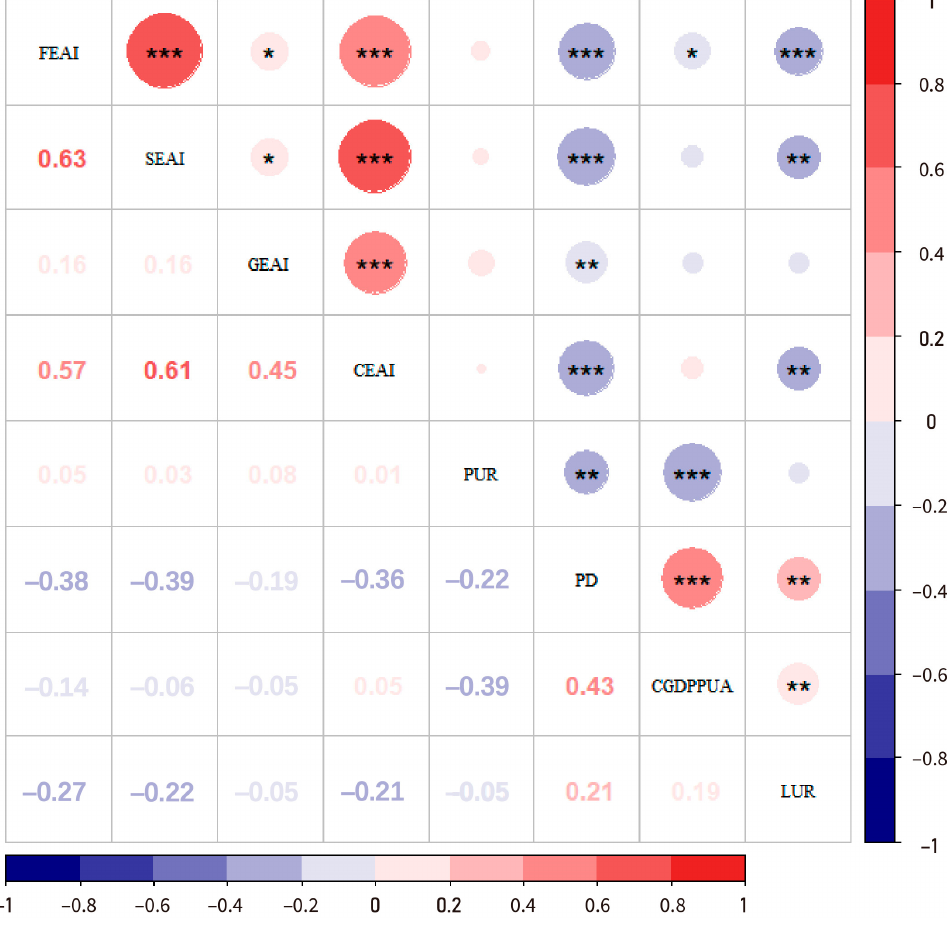
Figure 13. Correlation between county-level urbanization development and ecosystem asset index changes in the Beijing–Tianjin–Hebei urban agglomeration from 2000 to 2015. Note: *** represents a significant correlation at the 0.001 level; ** represents a significant correlation at the 0.01 level; * represents a significant correlation at the 0.05 level.